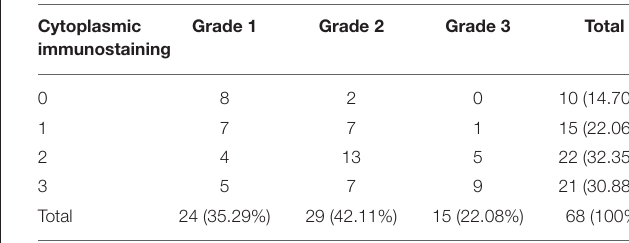
TABLE 6 | Cytoplasmic immunostaining in different